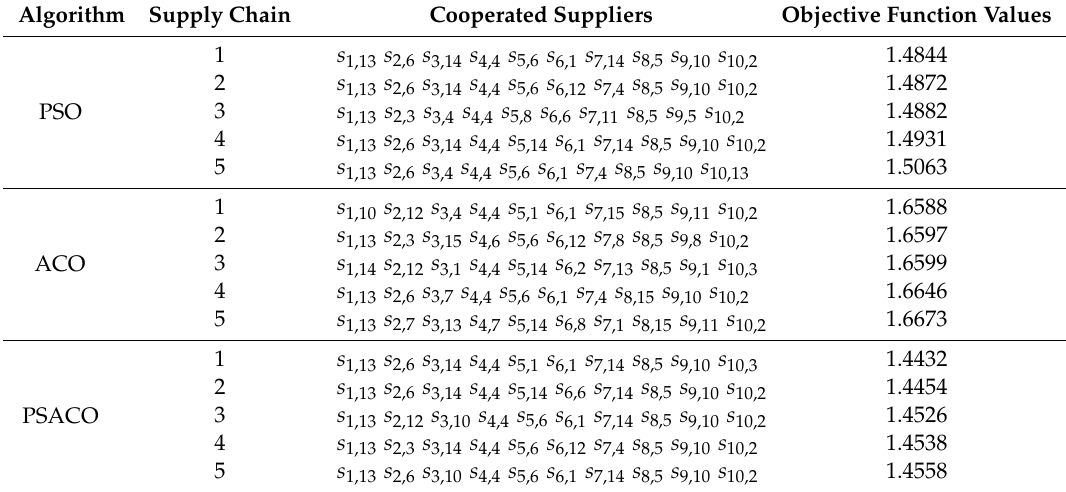
Table 3. Summary of